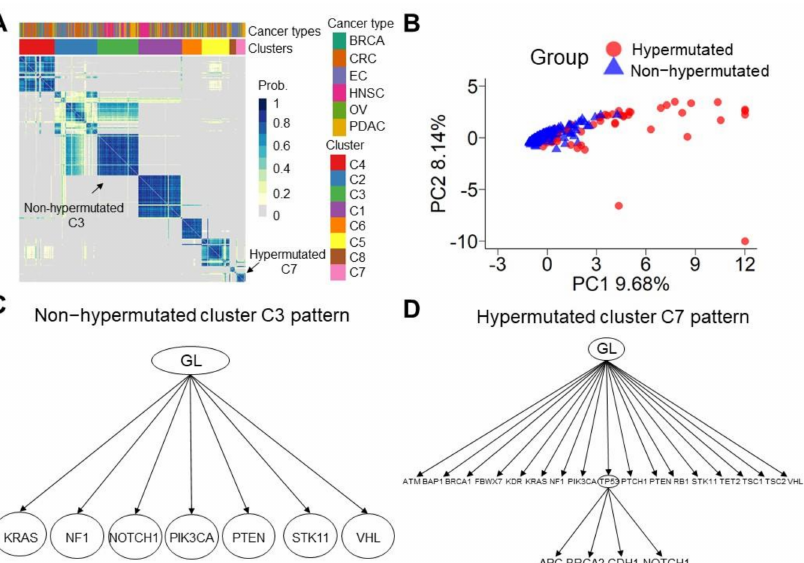
Figure 4. Sequential mutation clustering and trajectory analysis. ( A ) Coclustering heatmap of 533 patients with sequential mutations. A darker blue color indicates a higher probability of clustering together across each resample. Most hypermutated cancer patients are in C2, C7, and C8. ( B ) Principal component analysis (PCA) of hypermutated and nonhypermutated cancer pa- tients by sequential mutations. Red circles represent the hypermutated group, and purple trian- gles show the nonhypermutated group. ( C ) The nonhypermutated cluster 3 (C3) pattern. The sequential mutations that occurred at least ten times in C3 are plotted. The C3 pattern is com- posed of seven sequential mutations, including the germlines (GL)~ KRAS , GL ~ NF1 , GL ~ NOTCH1 , GL ~ PIK3CA , GL ~ PTEN , GL ~ STK11 , and GL ~ VHL . ( D ) The hypermutated C7 pattern. Seventeen sequential mutations that occurred at least ten times in C7 are plotted. The C7 pattern is com- posed of 17 sequential mutations in the first clone and 4 sequential mutations in the second clone: germline (GL) ~ ATM , GL ~ BAP1 , GL ~ BRCA1 , GL ~ FBXW7 , GL~KDR , GL ~ KRAS , GL ~ NF1 , GL ~ PIK3CA